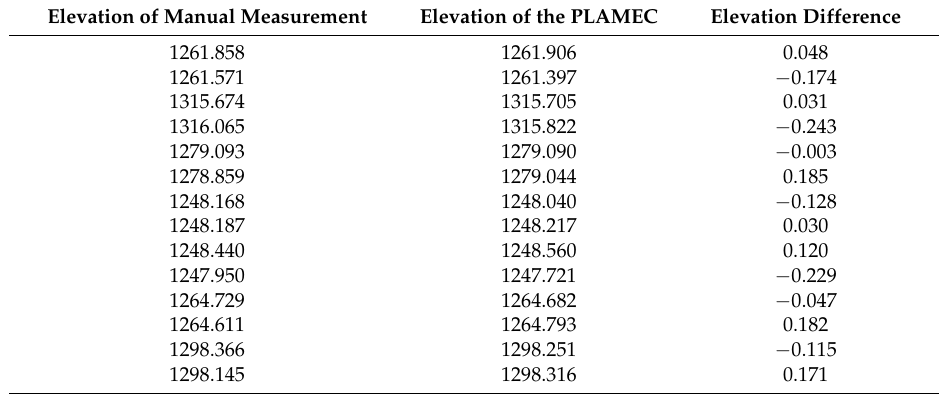
Table 3. Distribution of the elevation differences among sampling points in the power line profile (unit: m). Elevation of Manual Measurement Elevation of the